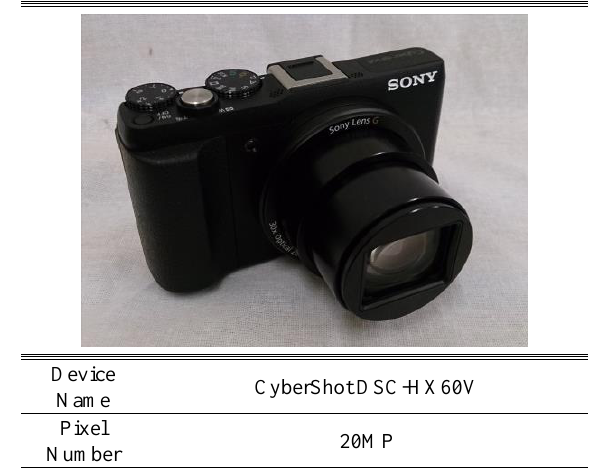
Table 1. Consumer grade digital